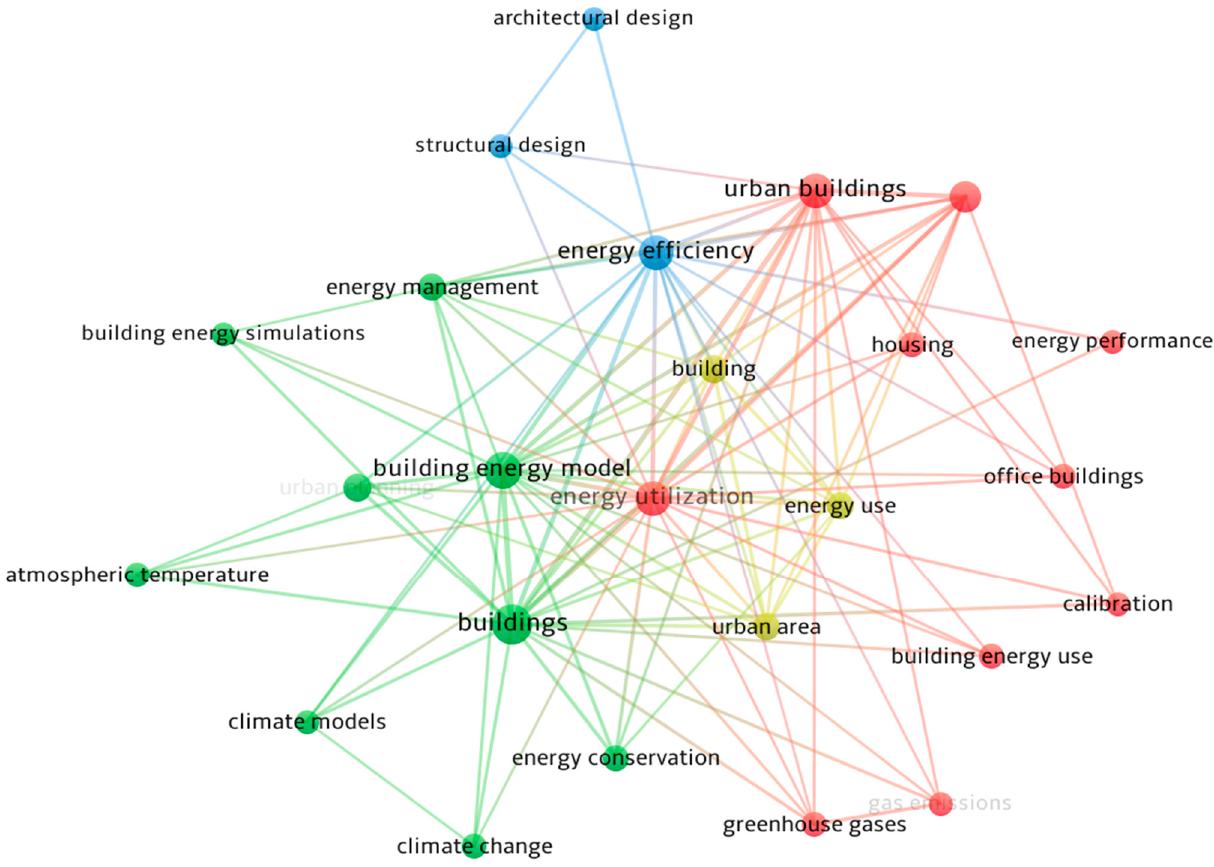
Figure 7. Keywords with the highest use in urban building energy modeling research studies developed by VOSviewer.